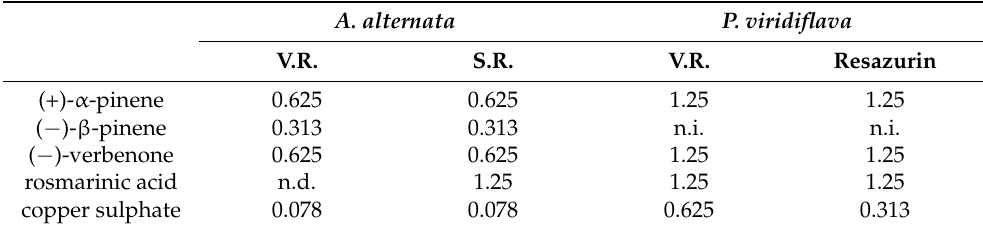
Table 2. Minimum inhibitory concentrations (MIC) of (+)- α -pinene, ( − )- β -pinene, ( − )-verbenone, rosmarinic acid and copper sulphate against A. alternata and P. viridiflava determined by the microdi- lution method and expressed as percentage.